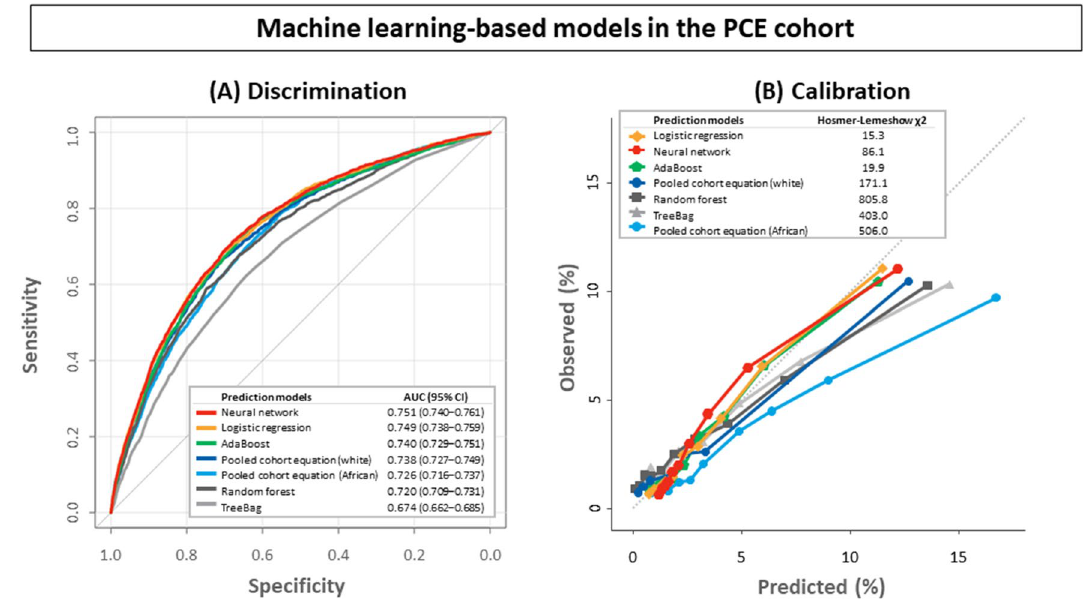
Figure 3. Discrimination and calibration of novel machine learning-based models in the test set of the pooled cohort equation (PCE) cohort. ( A ) Receiver operating characteristic curve analysis and ( B ) Hosmer– Lemeshow calibration plots of PCE and machine learning-based models. Risk score-specific predicted (x-axis) and observed events (y-axis) are depicted by deciles of calculated risk. Pooled cohort equation (white), pooled cohort equation for whites; pooled cohort equation for African Americans.